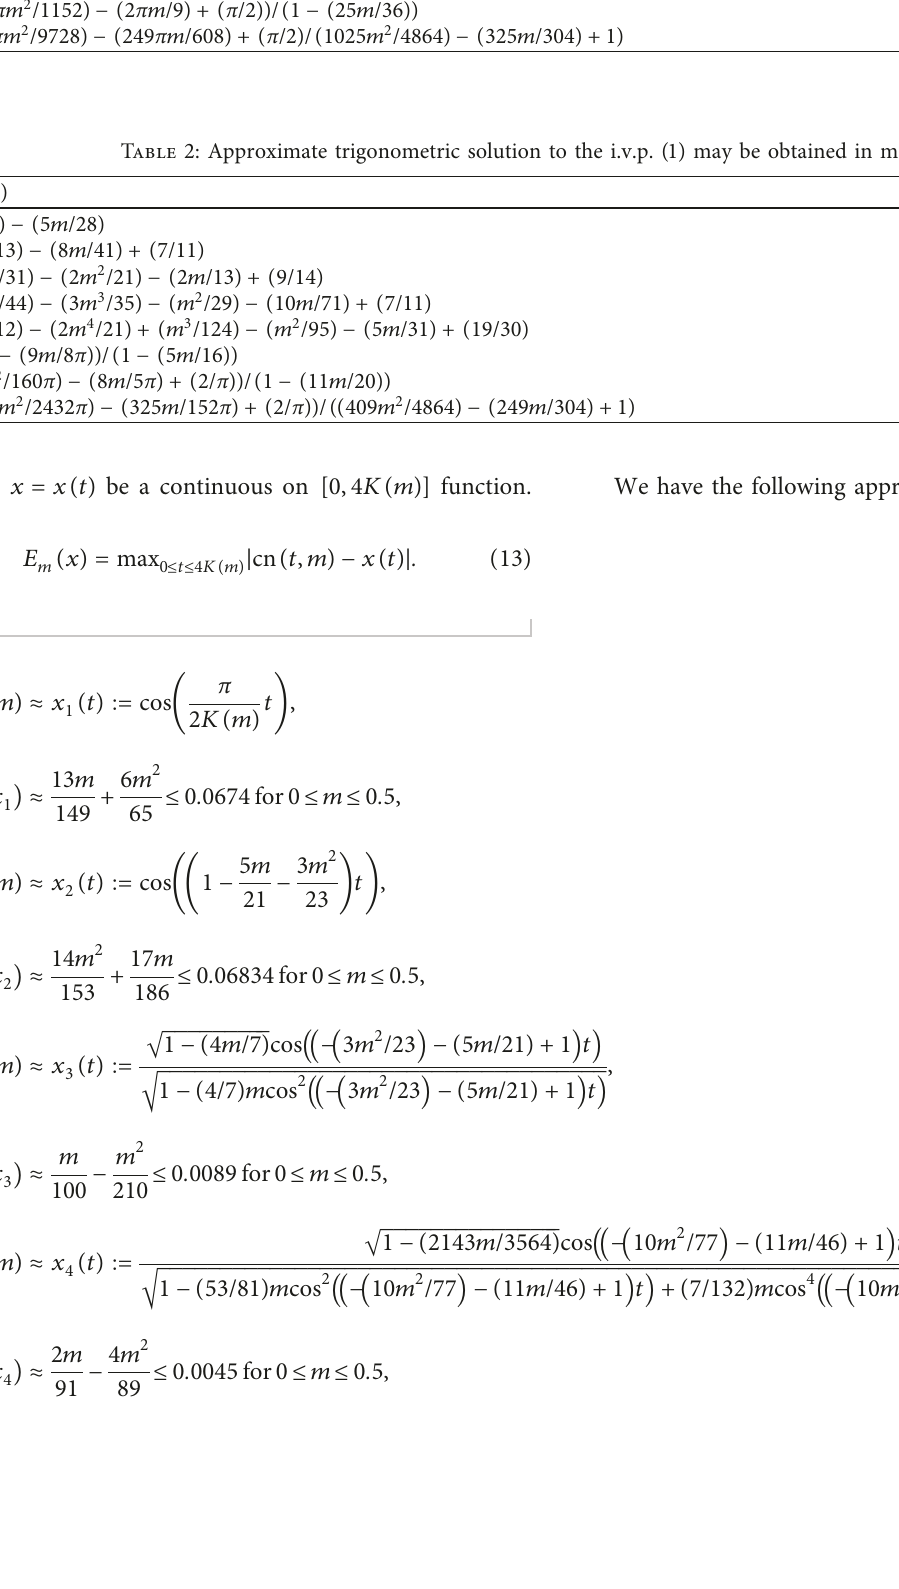
��������� √ ( d θ / ) . 1 − m sin 2 θ 0 Error on − 1 ≤ m ≤ 0 .